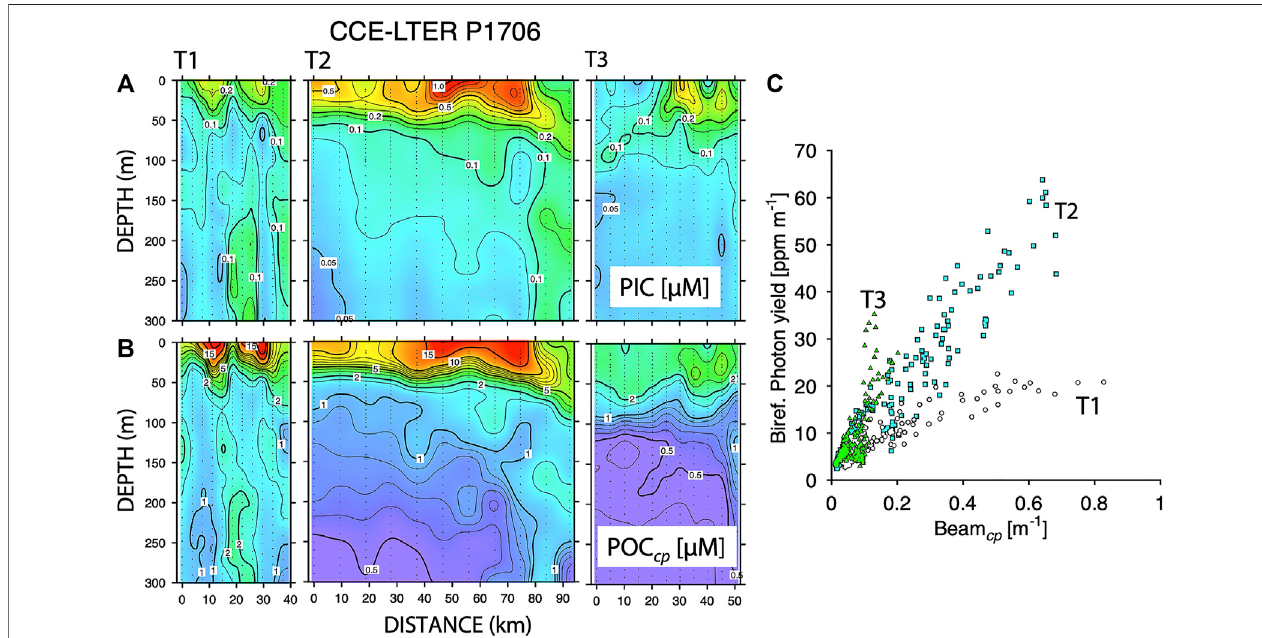
FIGURE 12 | (A) PIC sections for the upper 300 m during transects T1, T2, and T3 across the biologically productive fi lament sampled during the June 1 to July 2 2017 CCE-LTER process study, P1706. (B) POC section calculated from transmissometer beam attenuation coef fi cient data for the same transects. (C) Plot of birefringent photon yield against beam attenuation coef fi cient for transects T1 (circles), T2 (cyan squares), and T3 (green triangles). Results indicate that particle birefringence is independent from beam attenuation coef fi cient.